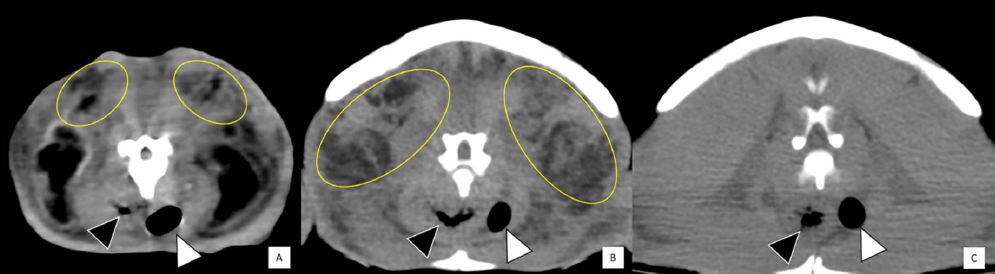
Figure 1. Gross appearance of steatitis in the right cervical region of a Kemp’s ridley sea turtle ( Lepidochelys kempii ) during necropsy. Discolored, necrotic adipose tissue is shown. The turtle is in dorsal recumbency with the head to the right of the image.